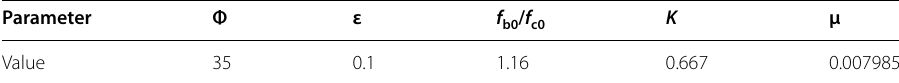
Table 2 Parameters used in CDP